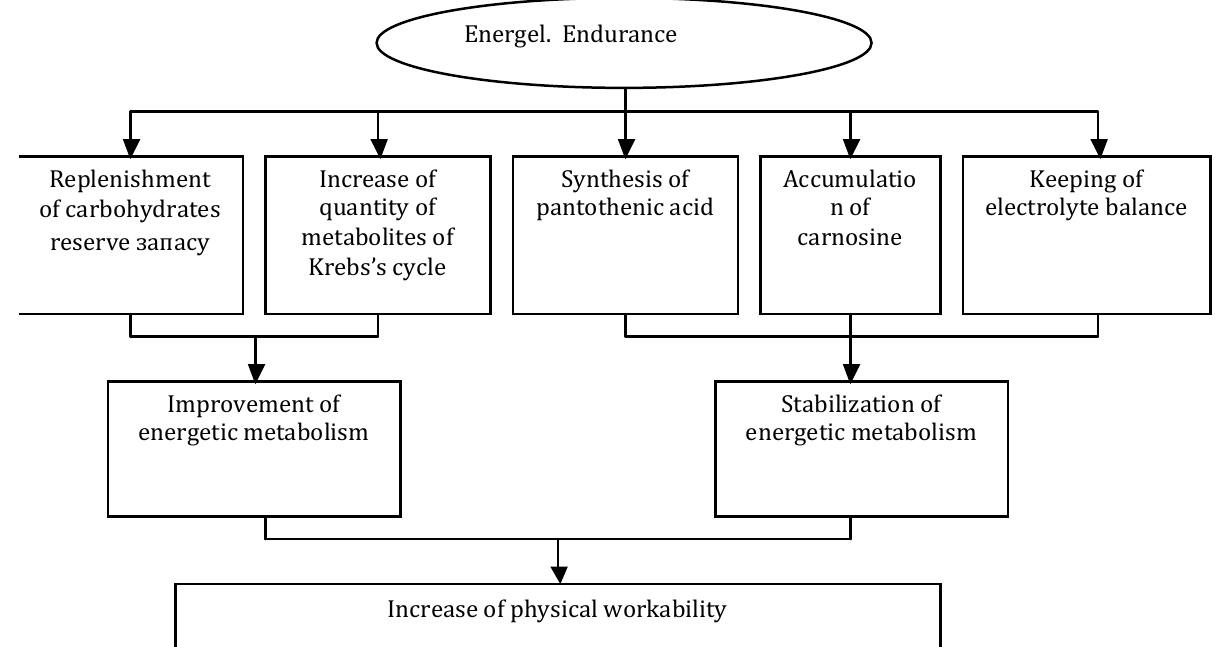
Fig. 4. Ways of realization of carbohydrate gel “Energel. Endurance” ergogenic influence under physical